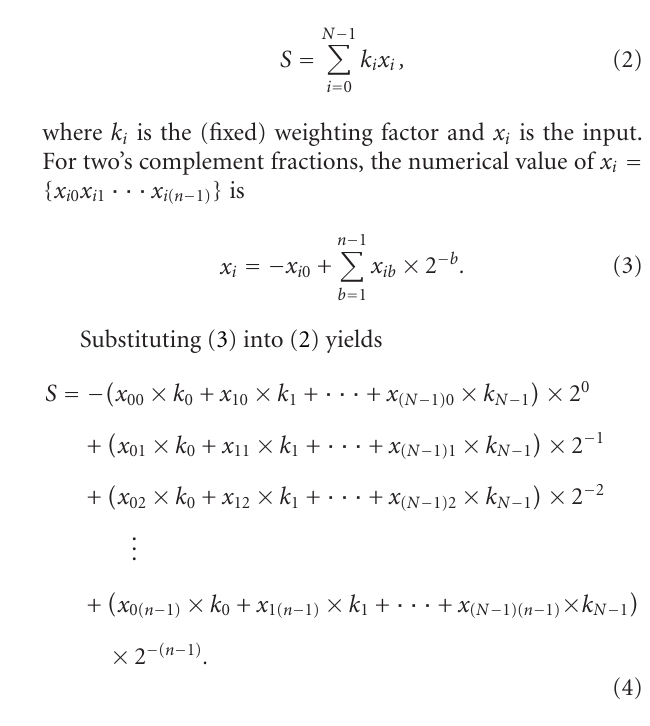
Figure 2: Illustration of a sine wave travelling through a simplified box model of an uncoiled cochlea (adapted from [2]).